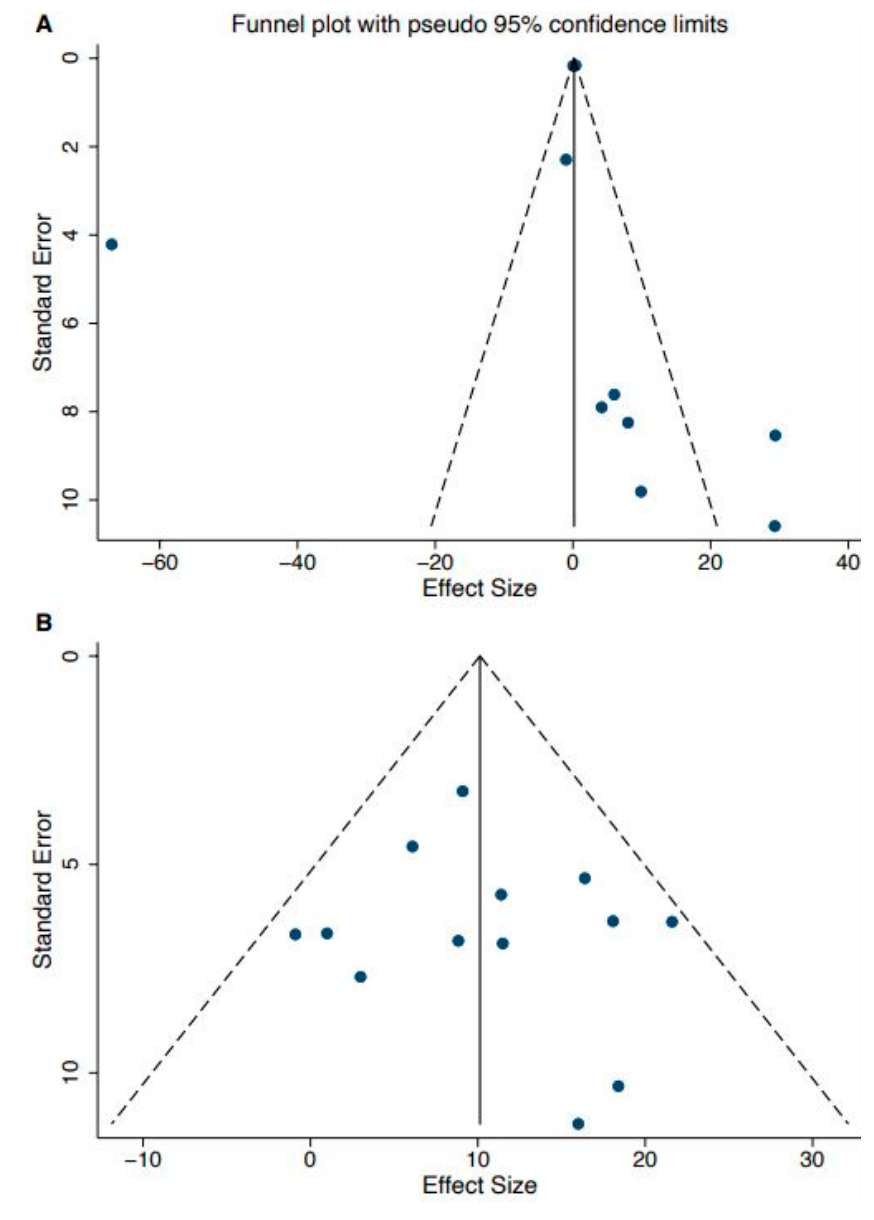
Figure 4. Funnel plot of Parkinson’s disease population—stride length ( A ), and stroke population—cadence ( B ).